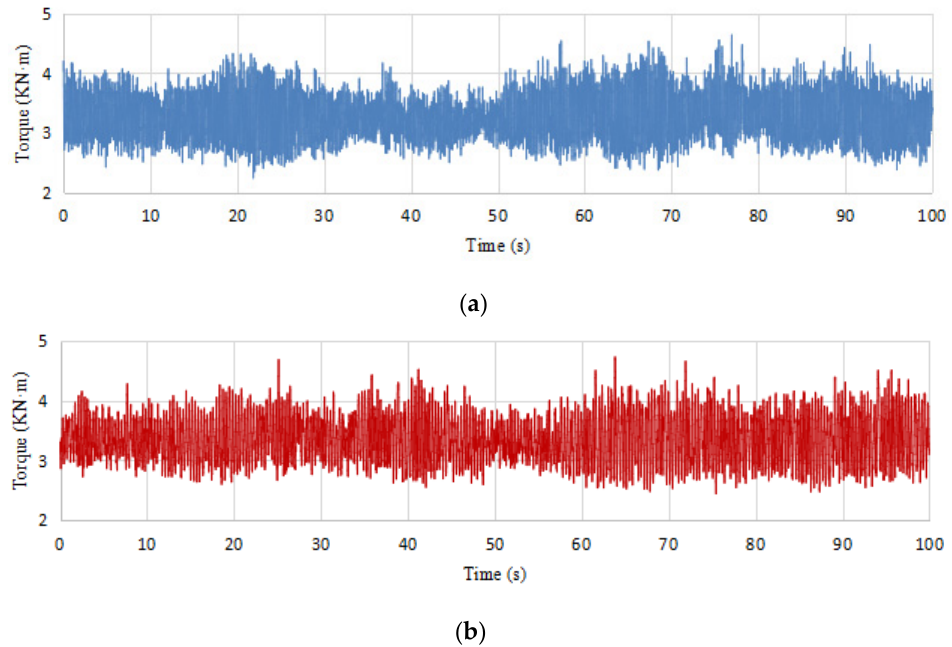
Figure 6. Compare measured torque and calculated torque. ( a ) The measured torque. ( b ) The calculated torque.